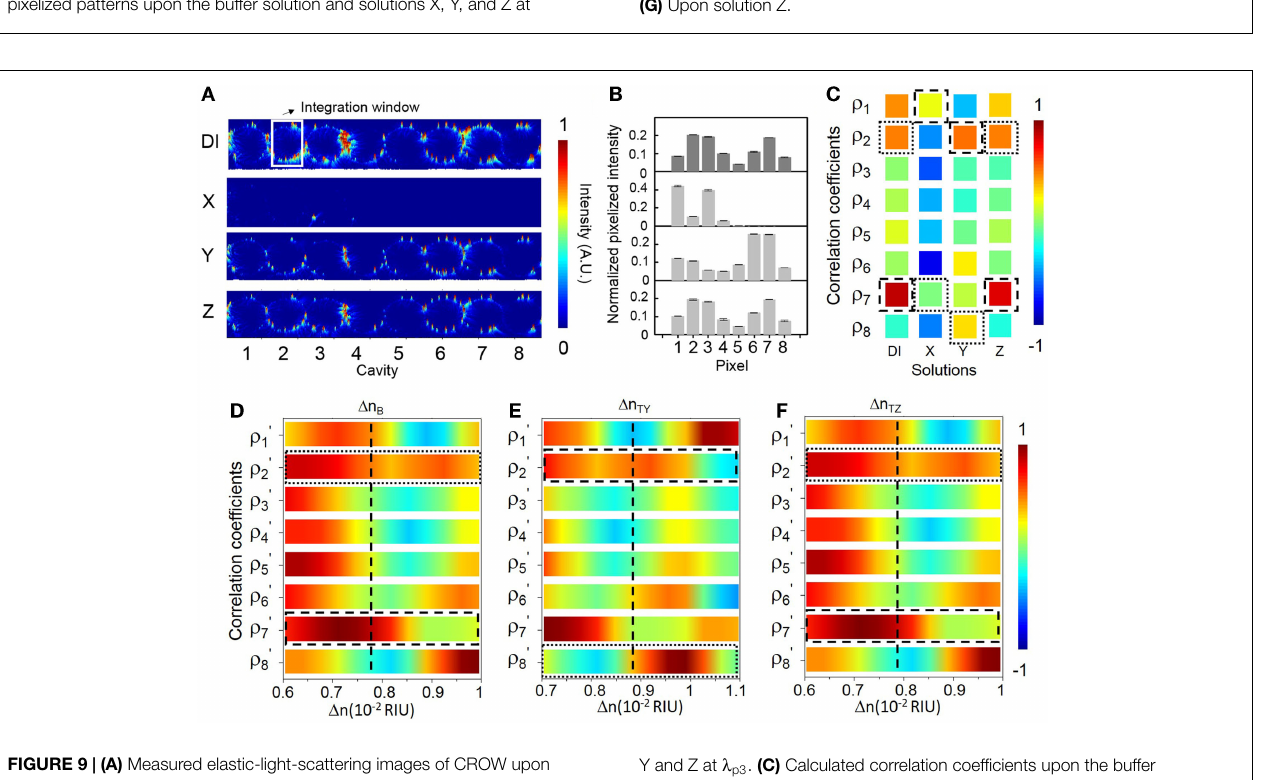
λ p2 . (C) Calculated correlation coefficients upon the buffer solution and solutions X, Y, and Z at λ p2 . Dashed-line and dotted-line boxes indicate ρ p and ρ s , respectively. (D–G) Zoom-in view of the library to extract ∆ n . (D) Upon the buffer solution. (E) Upon solution X. (F) Upon solution Y. (G) Upon solution Z.